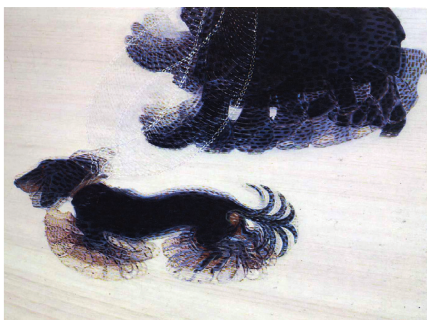
Figure 2: Dynamism of a Dog on a Leash by Giacomo Balla using chronophotography [10].